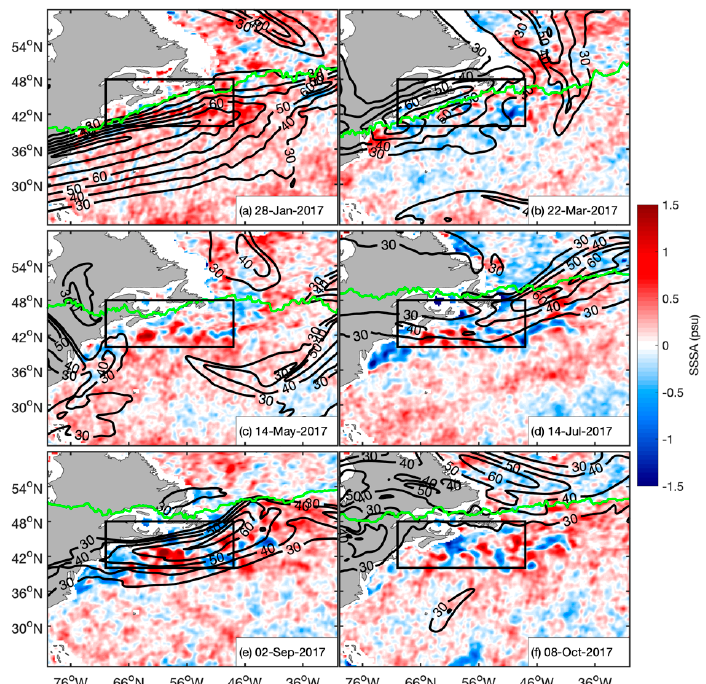
Figure 7. Spatial map of SSSA (psu) in the NW Atlantic throughout 2017. Black contour lines indicate wind speeds (m/s) at 300 hPa and the location of the Jet Stream. Green lines show the mean Jet Stream position based on the daily wind speed at 300 hPa from 1981–2020. Time series data was averaged over 40–48°N and 70–48°W indicated by the box.